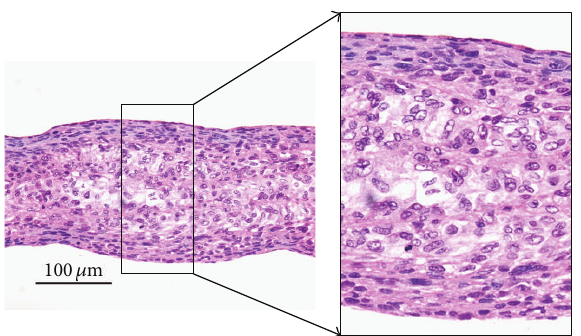
Figure 2: Histological observation of sextuple-layered hEMSC sheets. The left photograph is the cross-sectional observation of sextuple-layered cell sheets at 24h after layering. The right is an enlarged photograph of the center part of the left